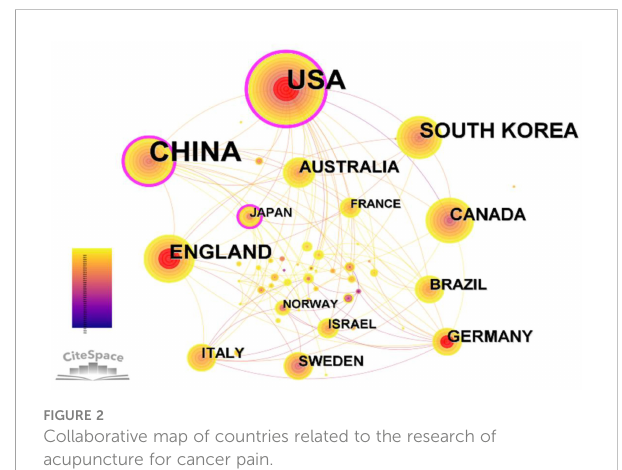
FIGURE 2 Collaborative map of countries related to the research of acupuncture for cancer